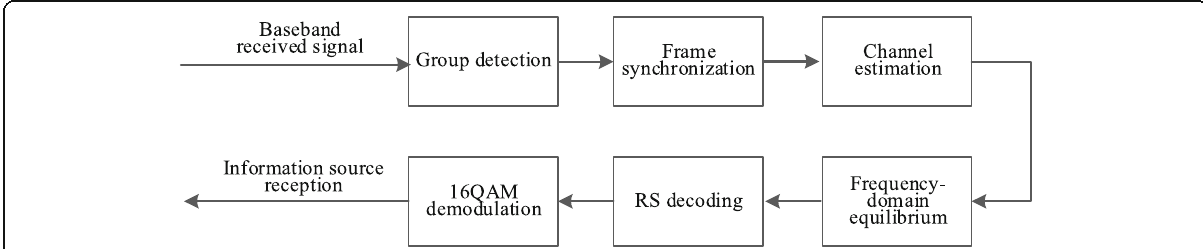
Fig. 2 The structure of the software radio receiver. The receiving terminal performs group detection, frame synchronization, channel estimation, frequency-domain equilibrium, RS decoding, and inverse